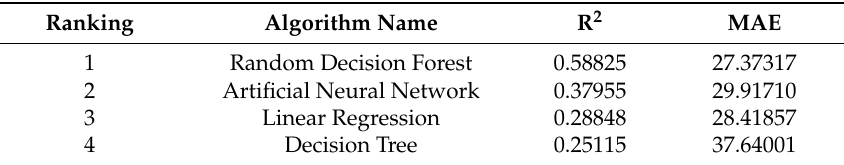
Figure 9. The relationship between the daily average of PM10 and multiple products: ( a ) MODIS Aqua AOD; ( b ) MODIS Terra AOD; ( c ) Modern-Era Retrospective analysis for Research and Applications version 2 (MERRA-2) AOD; ( d ) AERONET AOD at 1020 nm; ( e ) AERONET Ångström exponent (AE) at 340 nm / 440 nm; ( f ) predicted PM10 values from the Random Decision Forest model output. Table 3. The selected model per category. MAE: mean absolute